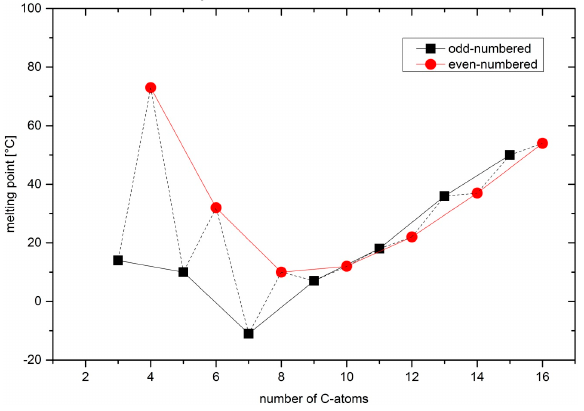
Figure 1. Melting point alternation of trans- α , β -unsaturated carboxylic acids in the series C3 to C16 .